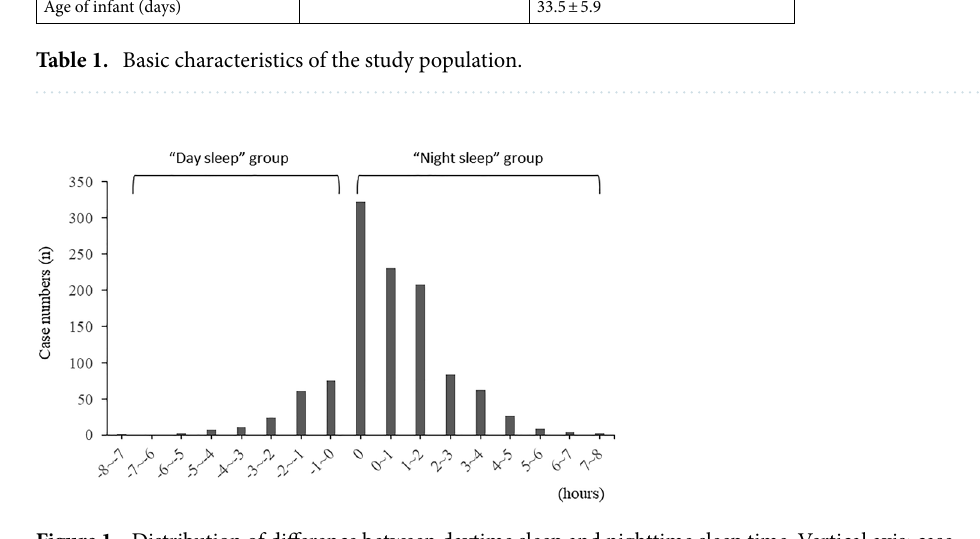
Figure 1. Distribution of difference between daytime sleep and nighttime sleep time. Vertical axis: case numbers, horizontal axis: Nighttime sleep time—Daytime sleep time (h). When Nighttime sleep time